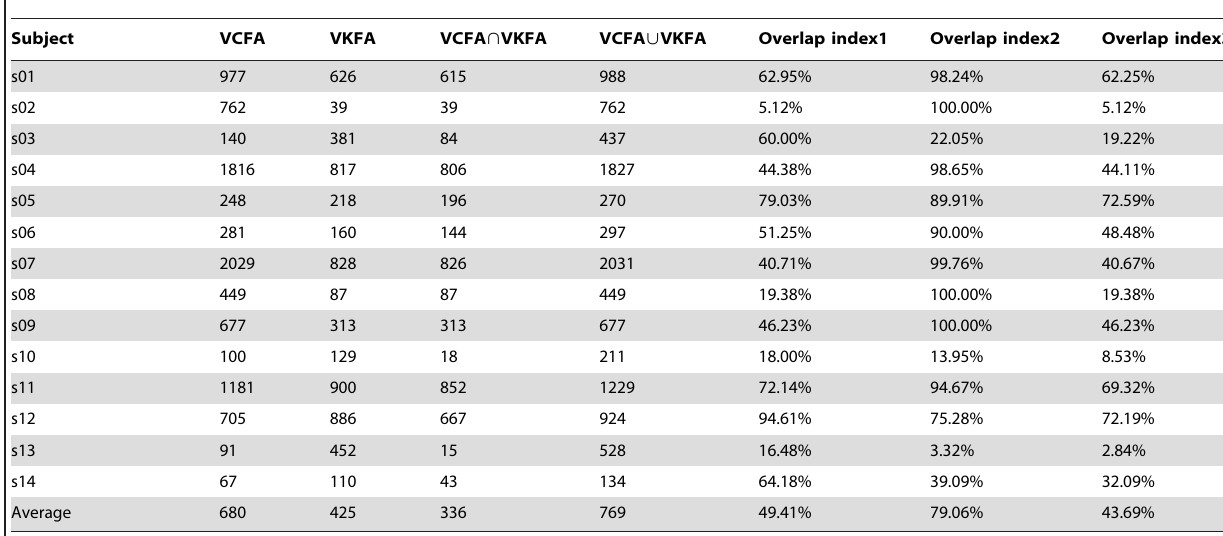
Table 2. Voxel number of VCFA, VKFA, VCFA > VKFA and VCFA < VKFA and overlap indexes between VCFA and